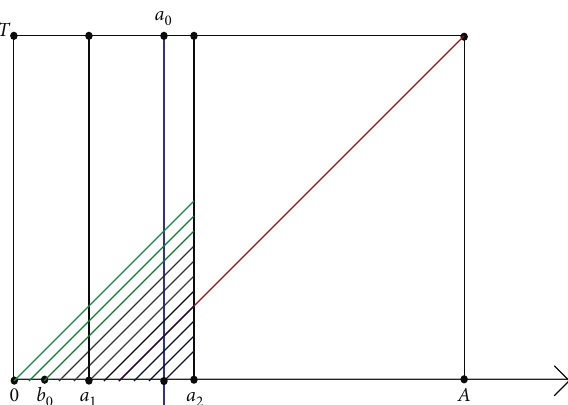
Figure 1: An illustration of the estimation of q ( a, 0 ) between 0 and a for case 1: green region corresponds to the interval ( 0 , b 0 corresponds to the interval ( b , a ) . interval ( a 1 0